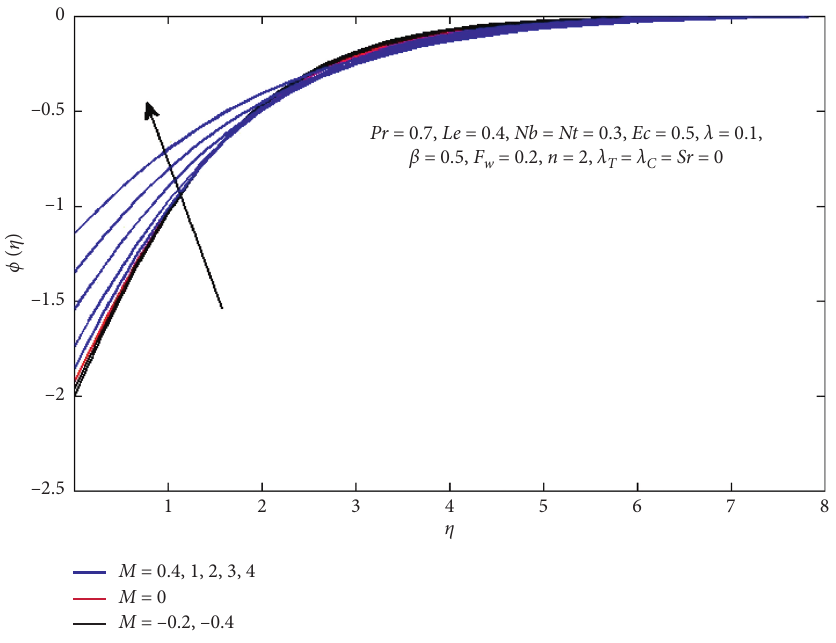
Figure 13: Variation of concentration ϕ concerning η with various values of M .